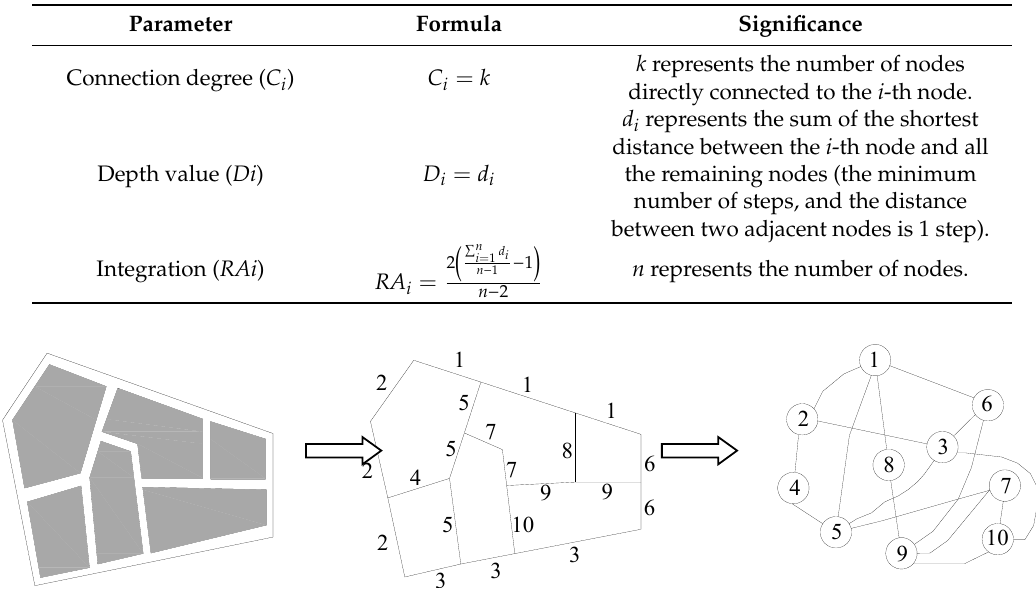
Table 1. Space syntax parameters.